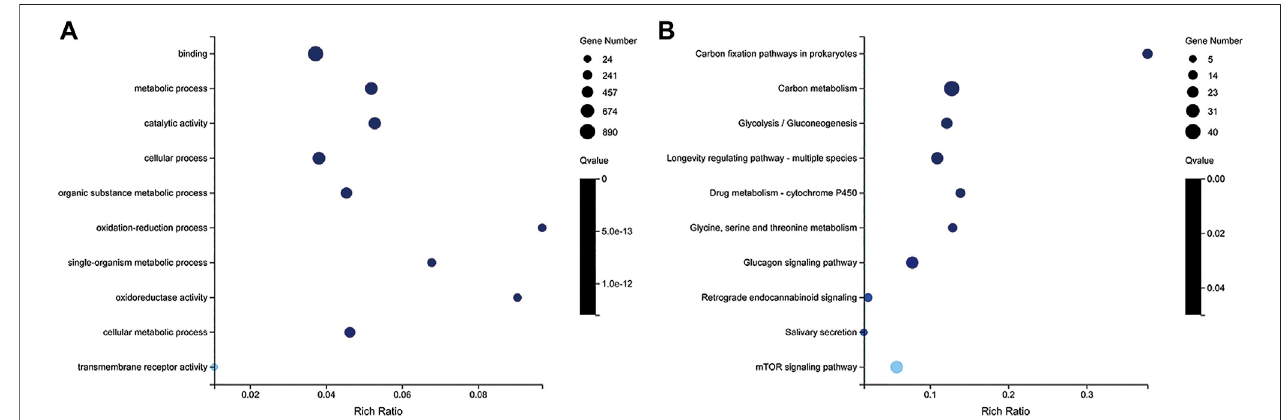
FIGURE6| GO (A) andKEGG (B) enrichment analysisofdifferentlyexpressed genes(DEGs)betweenLDand LW.They-axisrepresentstheenrichmentpathway, while the x-axis represents the enrichment factor. The dot sizes represent the number of DEGs. LW, liver from wild S. o ’ connori ; LD, liver from domestic S. o ’ connori .